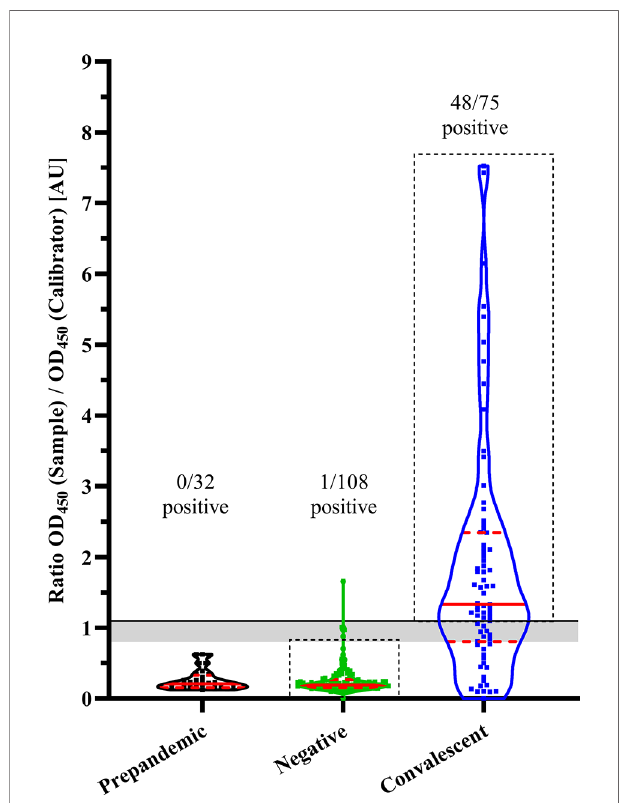
FIGURE 1 | SARS-CoV-2 IgG levels in plasma of adult control groups. IgG concentrations reactive to SARS-CoV-2 were estimated by commercial ELISA (EUROIMMUN). Results are shown as violin plots. Prepandemic: plasma collected 2015-2019, Negative: Individuals without (known) SARS- CoV-2 infection, Convalescent: Individuals with previous COVID-19. Solid line: Cut-off for SARS-CoV-2 IgG positivity; grey area: intermediate antibody concentration; solid red lines: median; dashed red lines: quartiles. Black dashed-line boxes highlight selected individuals for subsequent ELISAs.